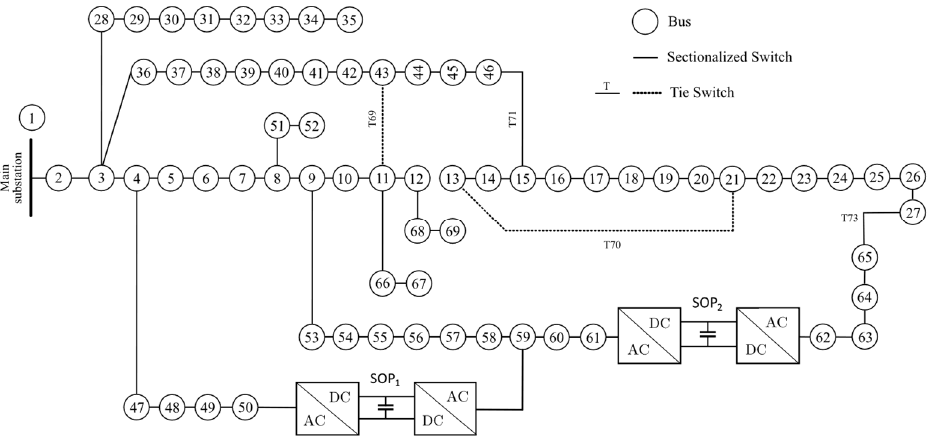
Figure 8. The optimal SR and two SOP locations for the IEEE 33-node radial DS.